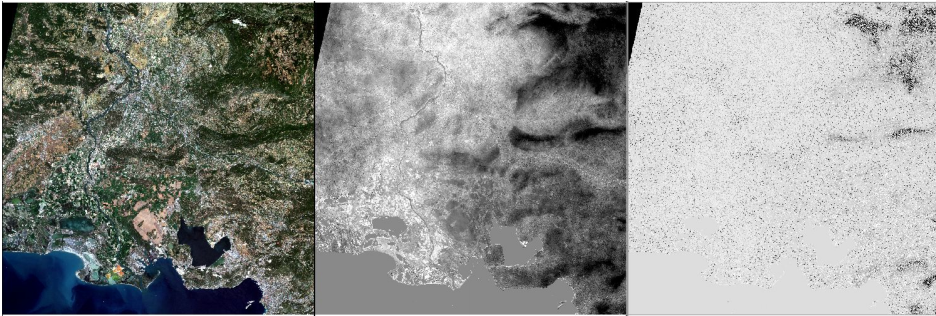
Figure 8. L1C RGB ( left ), WV map [in cm] Thuillier 2003 ( middle ) and WV relative difference map between TSIS and Thuillier product ( right ).